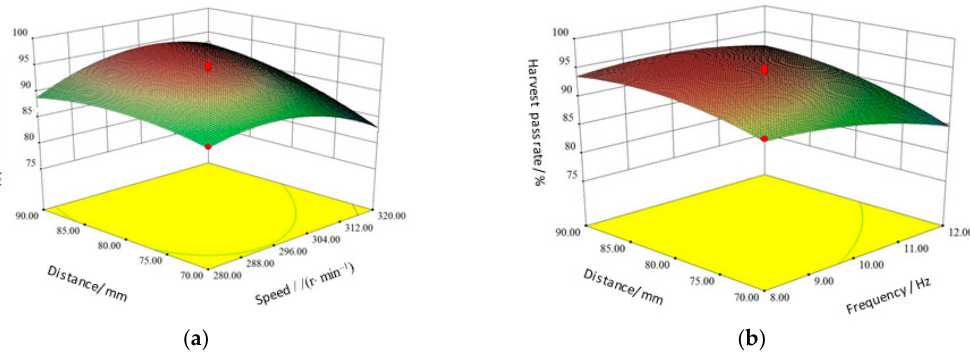
Figure 6. Response surfaces of factors’ interaction on harvest pass rate. ( a ) Y 2 = ( A , 0, C ); ( b ) Y 2 = (0, B , C ).